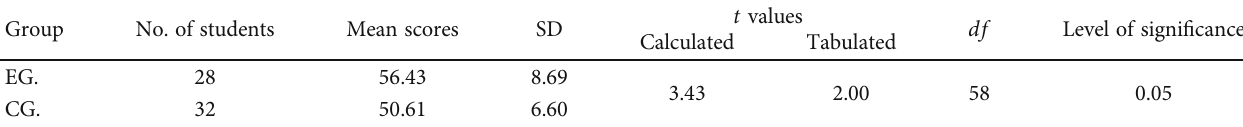
Table 4: The mean scores, standard deviations, and t values of the two groups on the achievement posttest. Group No. of students